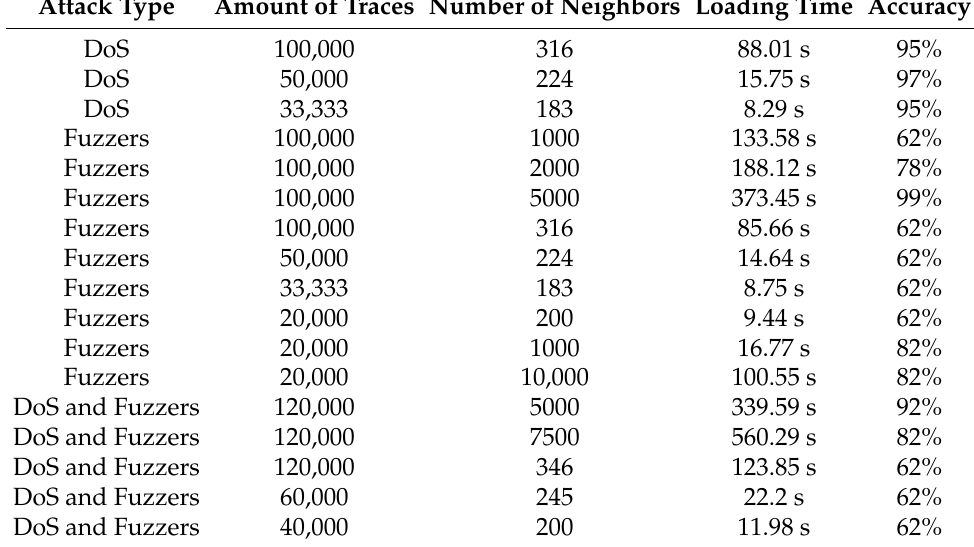
Table 4. Machine learning